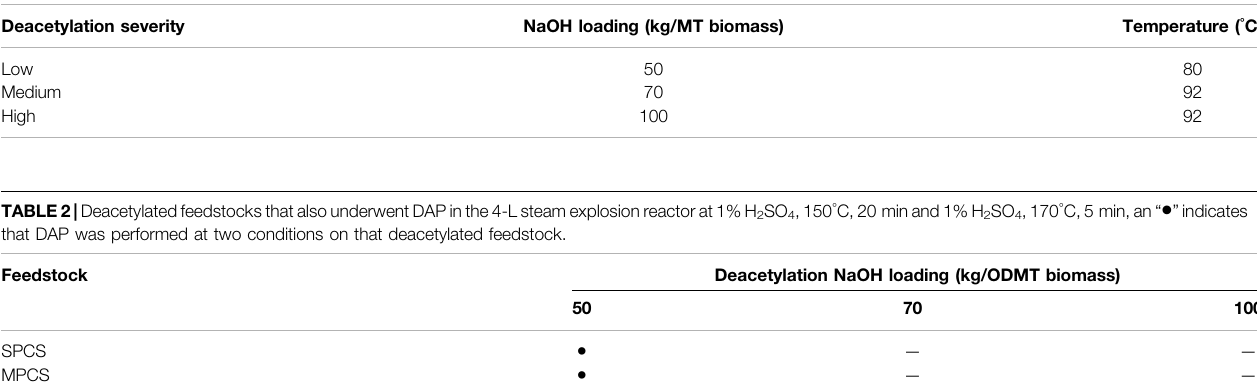
TABLE 1 | Deacetylation alkali loading and temperature for all feedstock types in experiments. Deacetylation severity